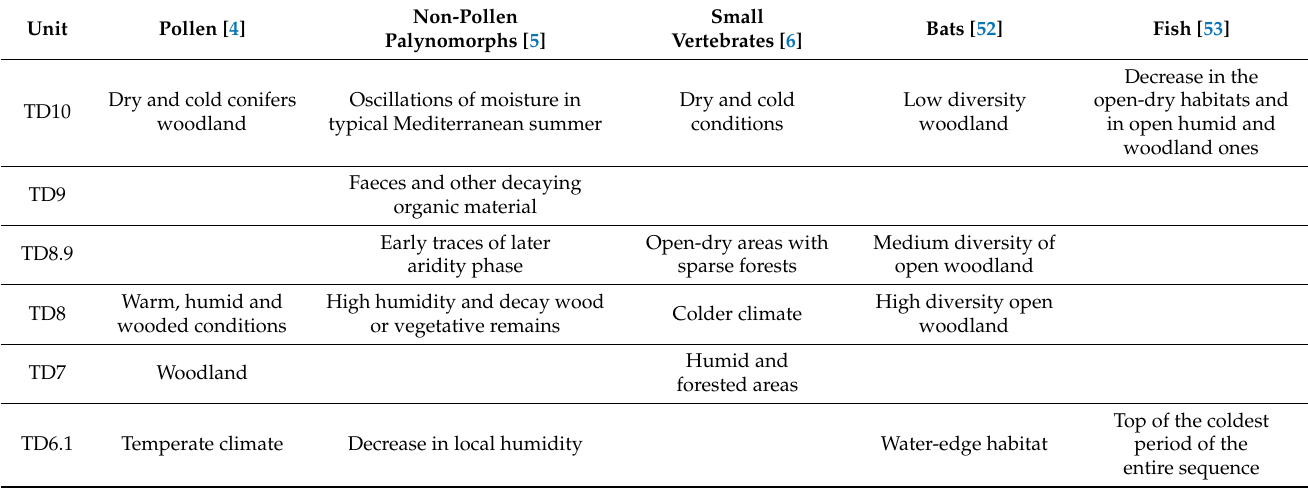
Table 4. Climatic and palaeoenvironmental reconstruction derived by previous studies using different climatic